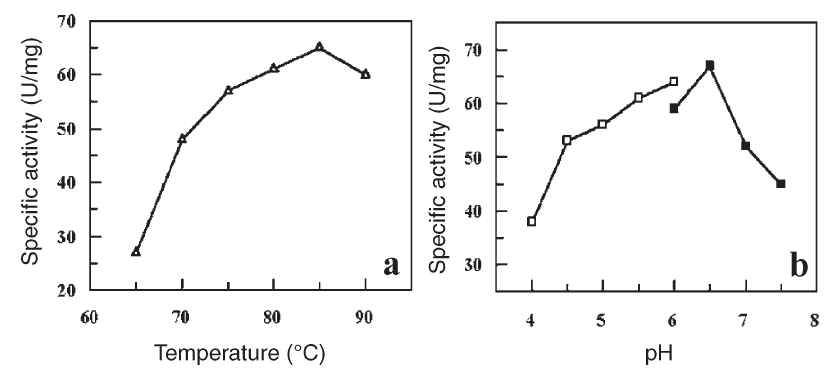
Figure 6. Affinity of Sso N long: tempera- ture (a) and pH (b) responses.